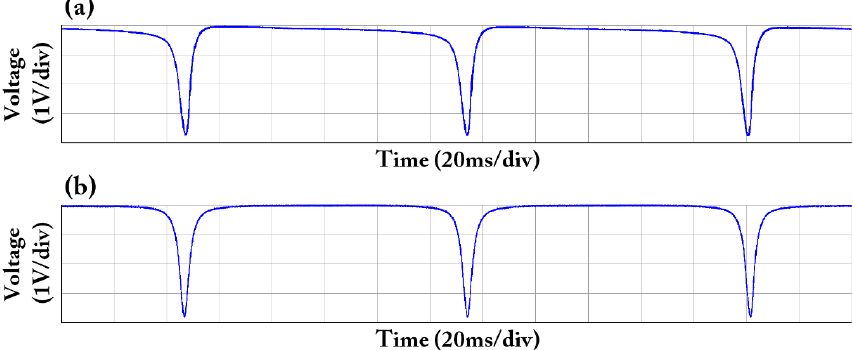
Figure 6. Measured resonant curve of the two different couplers connected to FRR. ( a ) C2 #1 ; ( b ) C2 #2